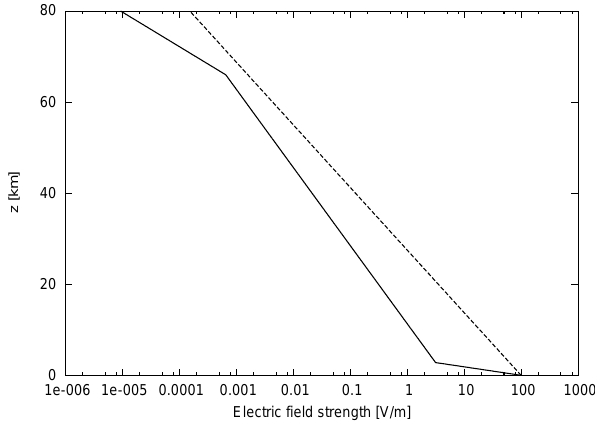
Fig. 5. Height distributions of the maximum values for the vertical electric field E z (a/ 3 ,z) in this model (solid line) and E z ( 0 ,z) in the model of Denisenko et al. (2008) (dashed line).